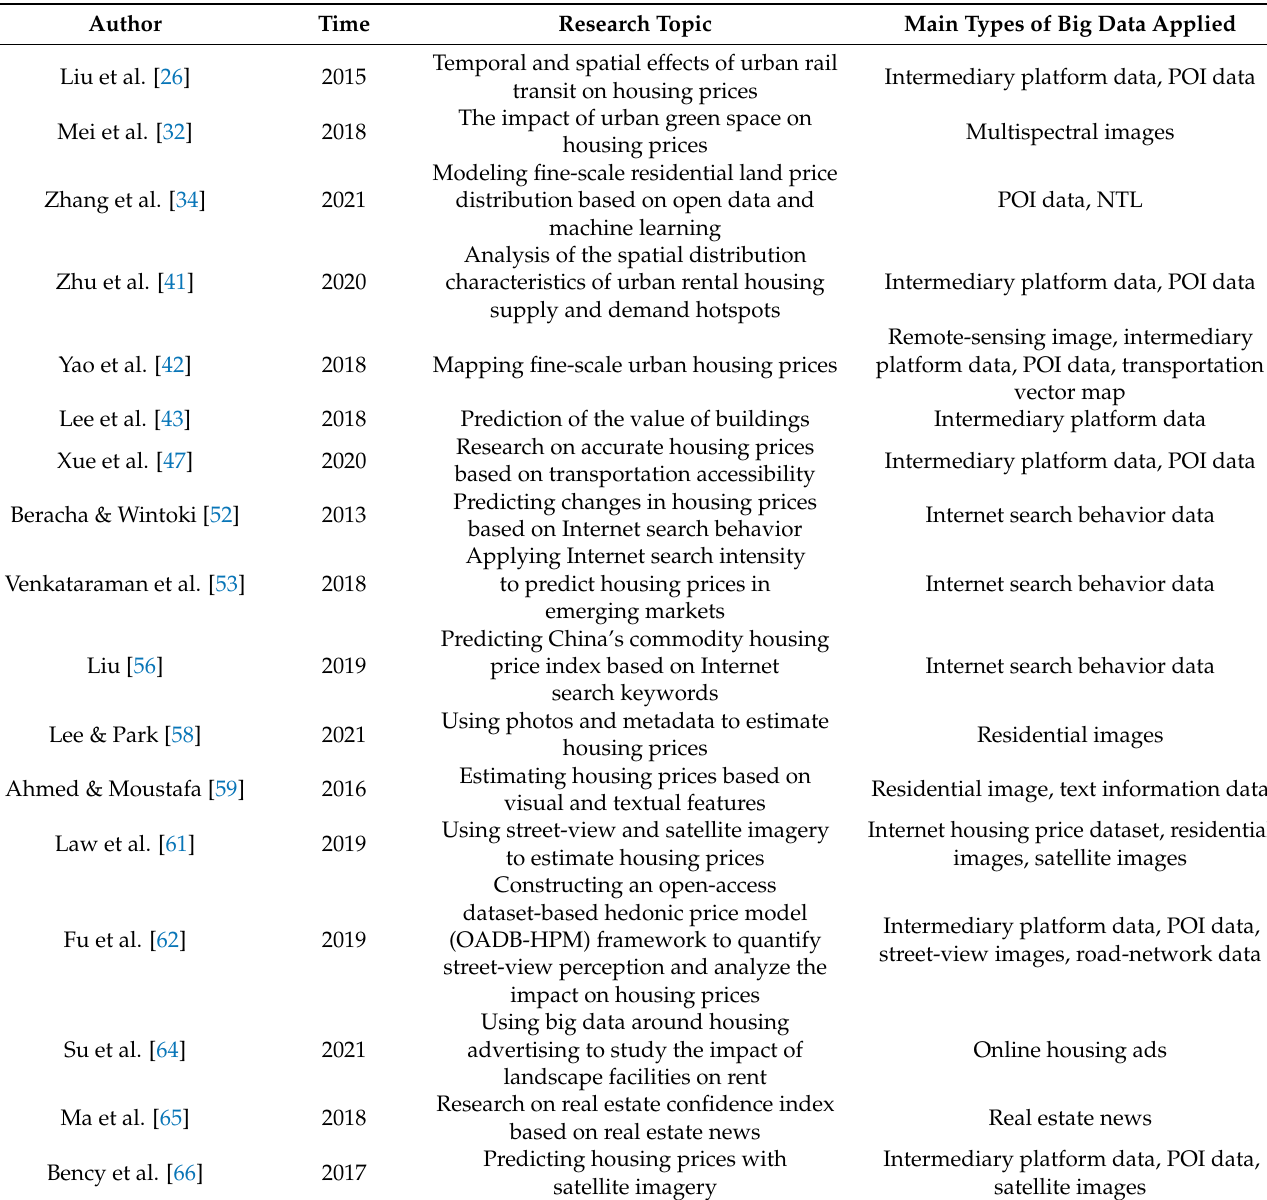
Table 1. Typical big data applied in real estate